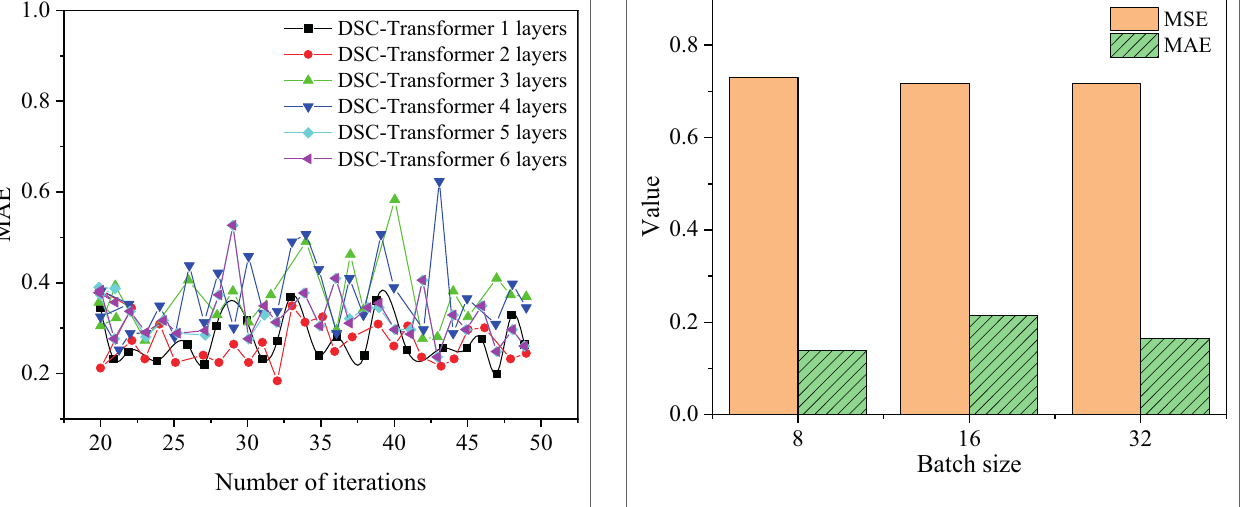
FIGURE 7 | The mean absolute error (MAE) value of the DSC-Transformer structure with different layers used in the prediction model.